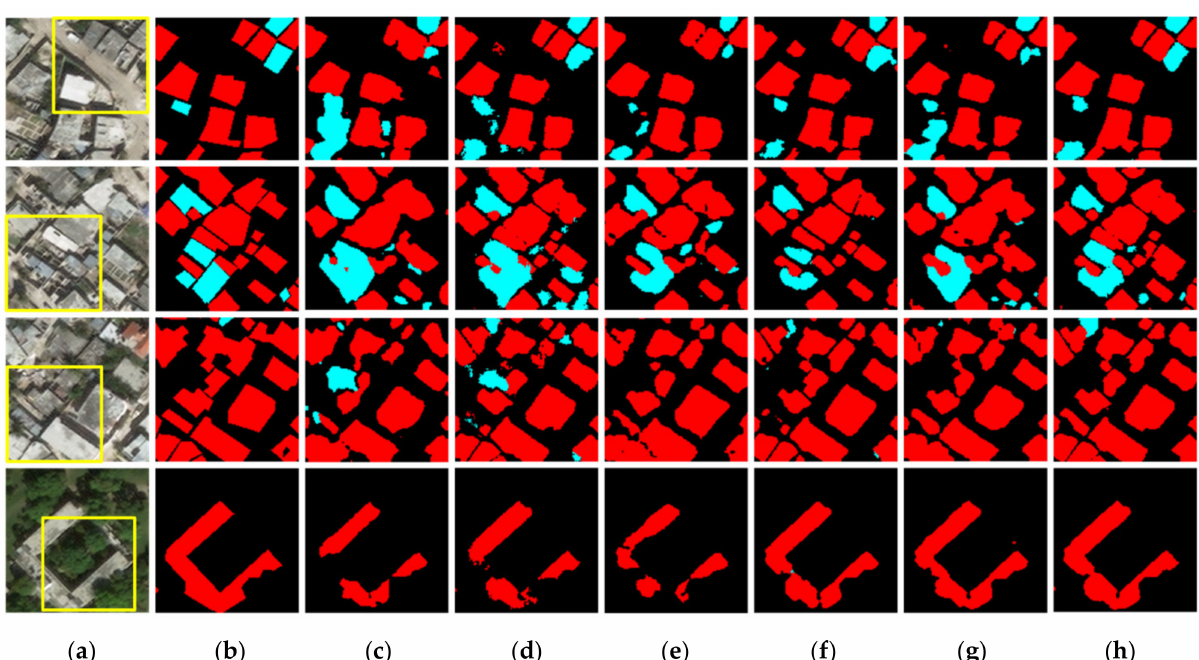
Figure 11. Detection results of the HTI dataset by different networks: ( a ) original image; ( b ) ground truth map; ( c ) DeepLabv3+; ( d ) UNet; ( e ) MobileNetV2+CA; ( f ) UNet 3+; ( g ) OB-DeepLabv3+; ( h ) OB-UNet; red, blue and black in ( b – h ) separately represent non-collapsed buildings, collapsed buildings and the others.